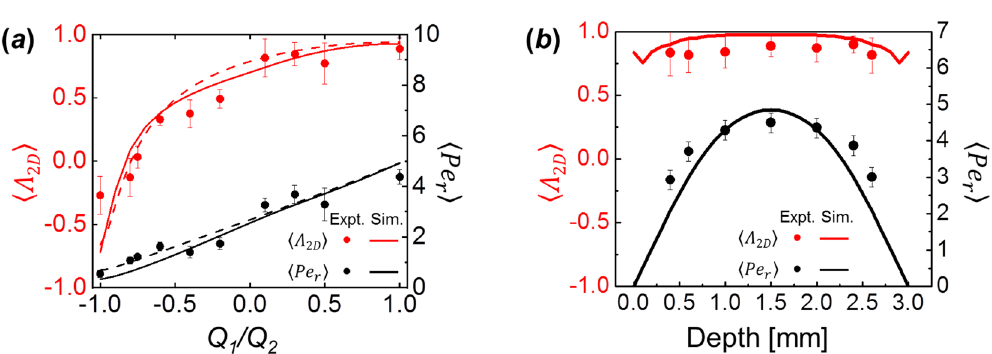
Figure 10. Experimental (points) and simulated (lines) flow mapping for a shear thinning fluid in the FFoRM geometry. Simulation results included are for a GNF fluid with viscosity described by the Carreau model (solid lines). Results for a Newtonian fluid are included for reference (dashed lines). The volume averaged 2D flow type parameter ( Λ 2 D , red) and rotational Peclét number ( 〈 Pe r 〉 , black) are included as a function of ( a ) the operating parameter ( Q 1 / Q 2 ) at the center plane of the geometry for constant Q 2 = 1.0 mL/min ( Re = 0.005) and ( b ) the depth through the device for constant Q 1 = Q 2 = 1.0 mL/min ( Re = 0.005). Error bars in the experimental measurements are the standard deviations of the measured average value in the beam